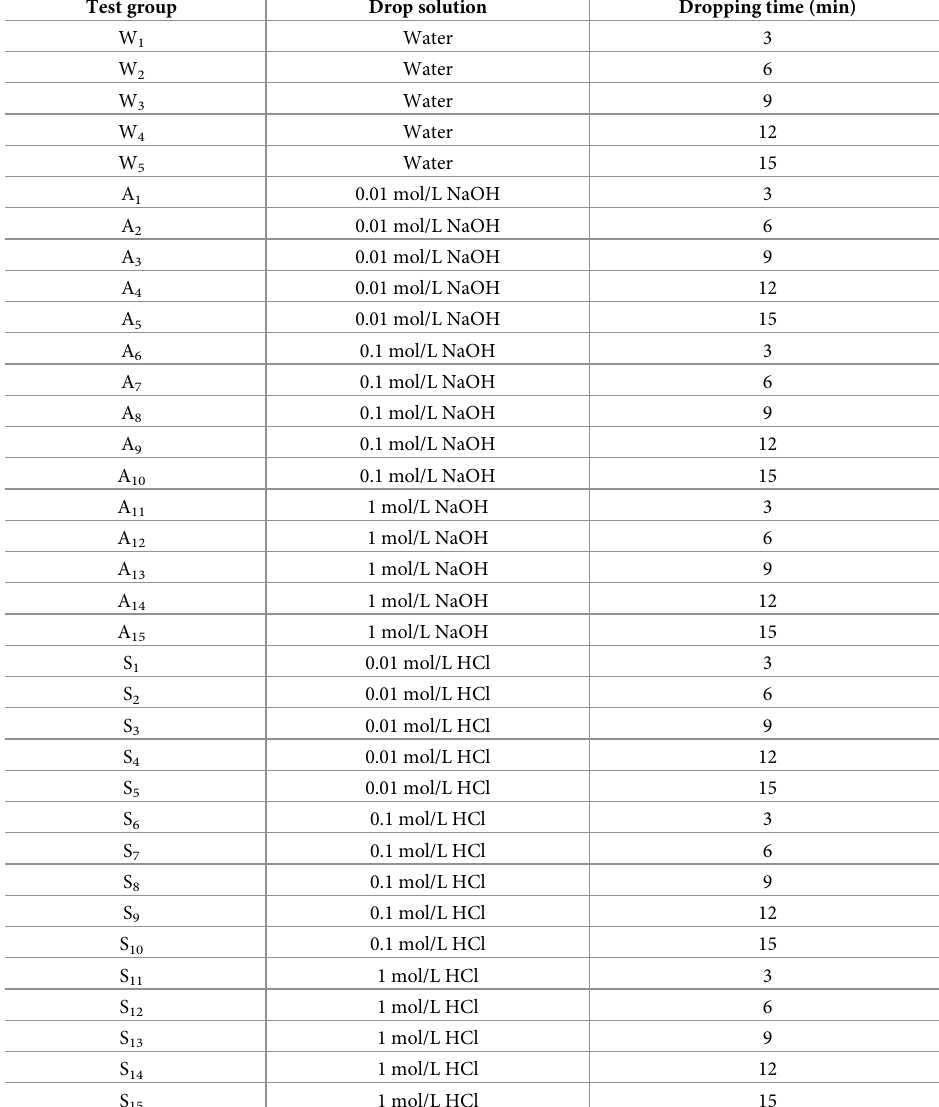
Table 2. Test of water, acid and alkali resistances of naturally weathered red-bed